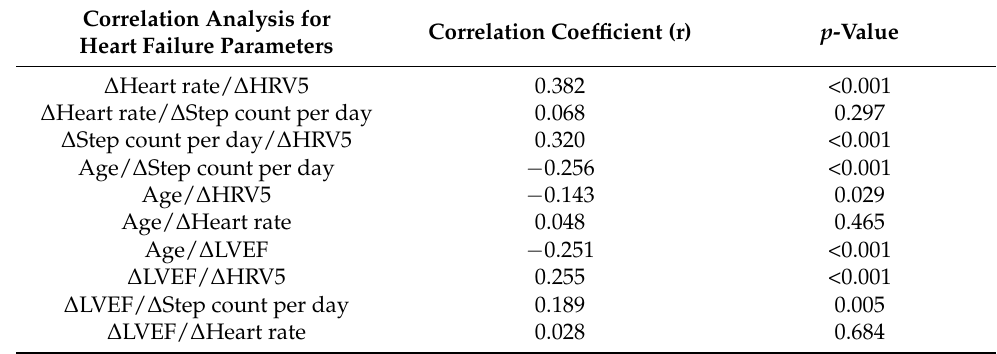
Table 3. Correlation analysis: Changes in heart failure parameters between the first and last seven days of usage, and, for left ventricular ejection fraction, between prescription and end of WCD wear time, respectively; WCD = wearable cardioverter–defibrillator; LVEF = left ventricular ejection fraction; HRV5 = heart rate variability